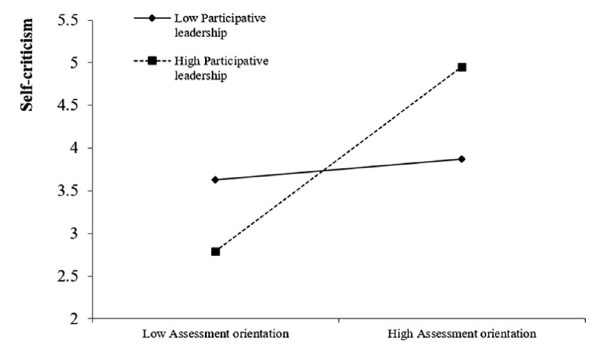
FIGURE 2 | Interaction effect of assessment orientation and participative leadership on